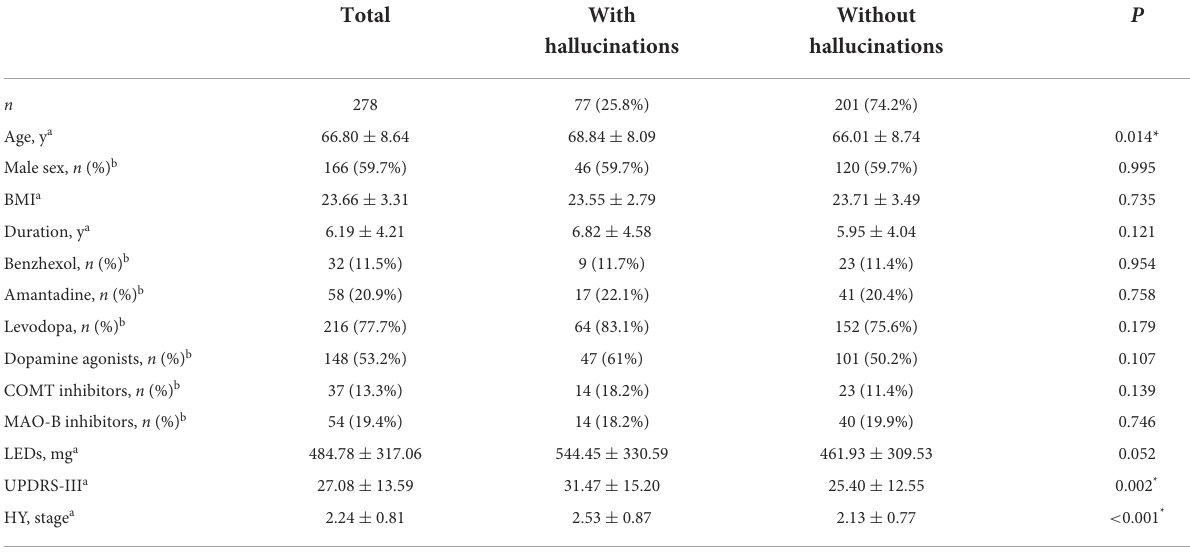
TABLE 2 Demographic and clinical characteristics of Parkinson’s disease patients based on the presence/absence of hallucinations. Total With Without hallucinations hallucinations